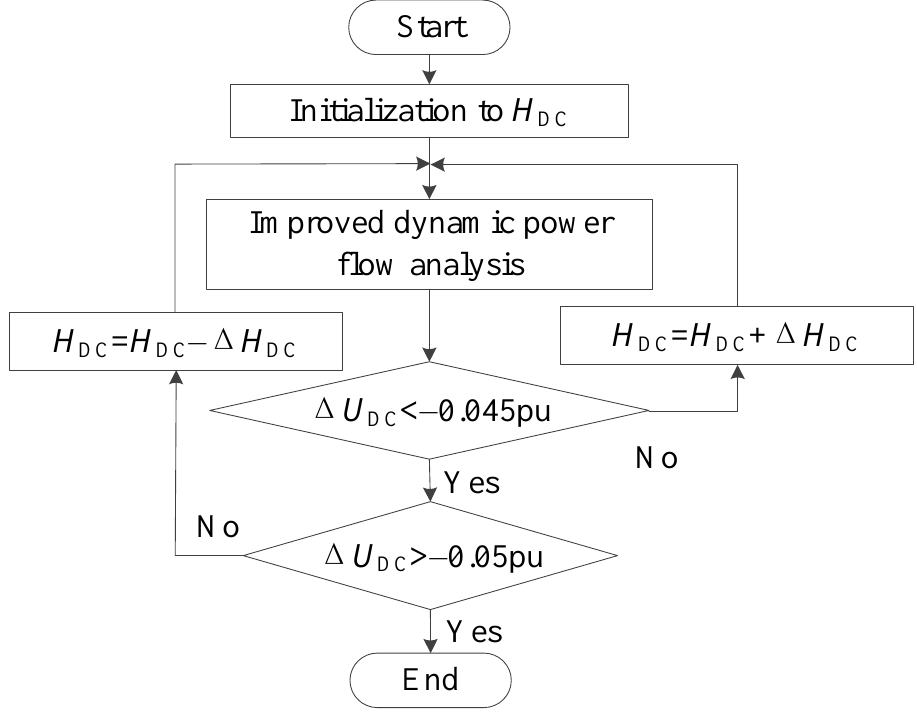
Figure 6. Optimization to H DC using improved DPF model.